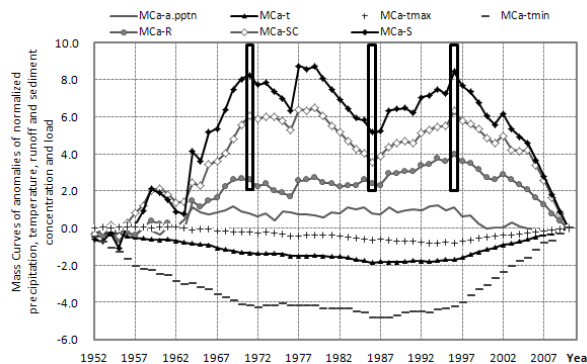
Fig. 4. Mass curves of anomalies of normalized characteristics of GHS in 1952-2010 2 (The boxes in the figure are the change points) 3